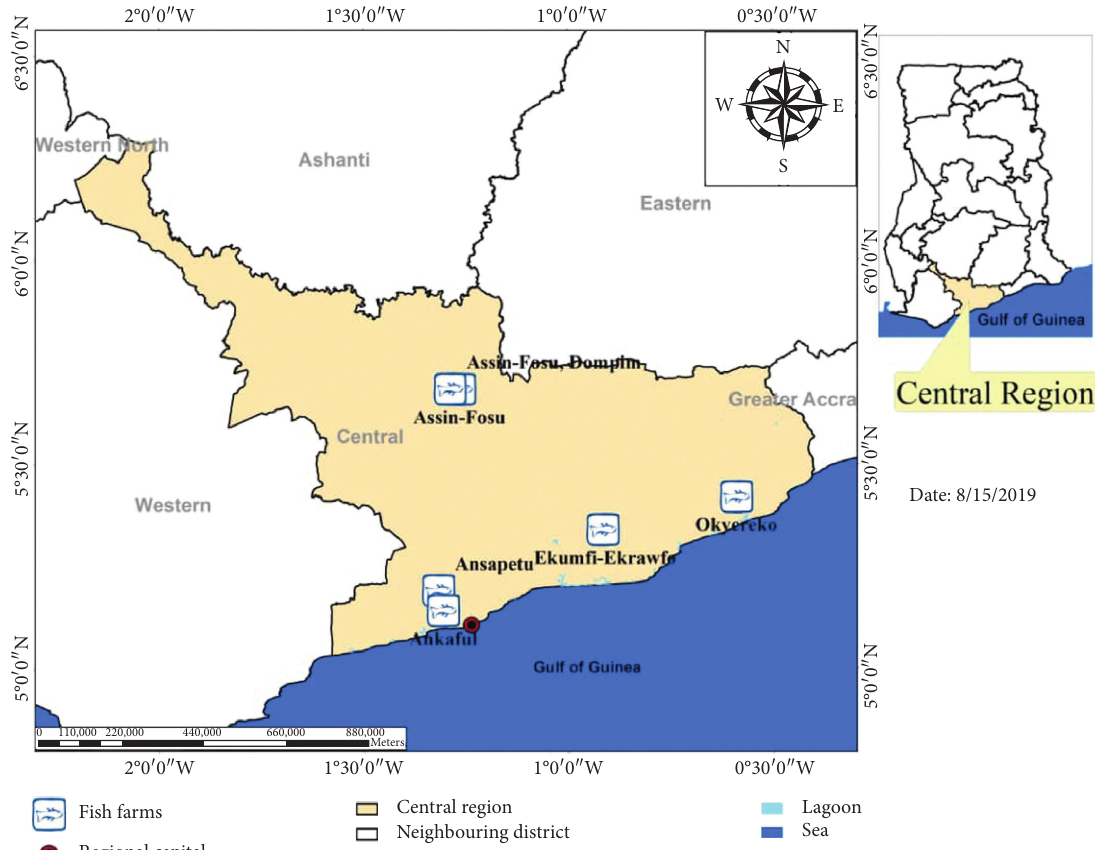
Figure 1: Geographic distribution of fish farms